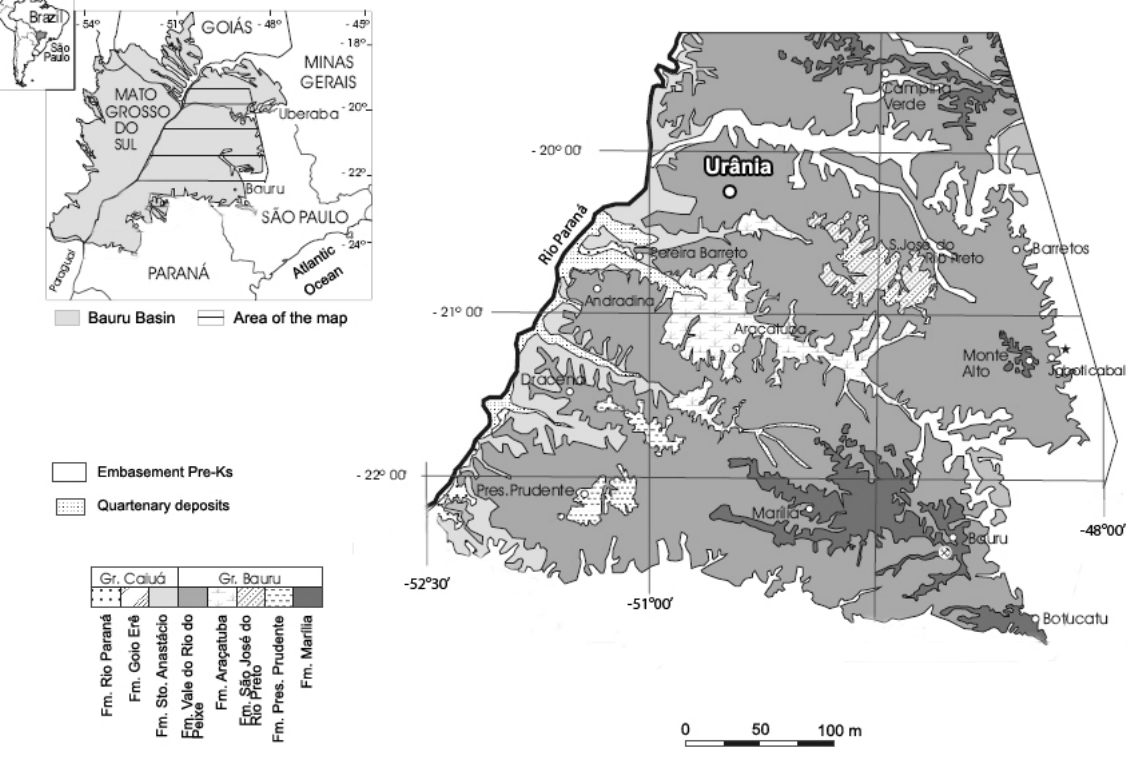
Fig. 1 – Location of the study area and stratigraphy of Bauru Basin (modified from Fernandes and Coimbra